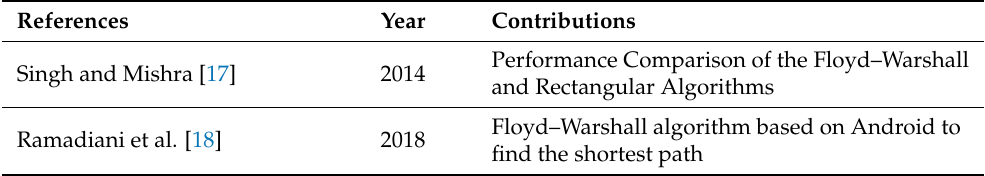
Table 2. Use of the Floyd–Warshall algorithm for determining the best